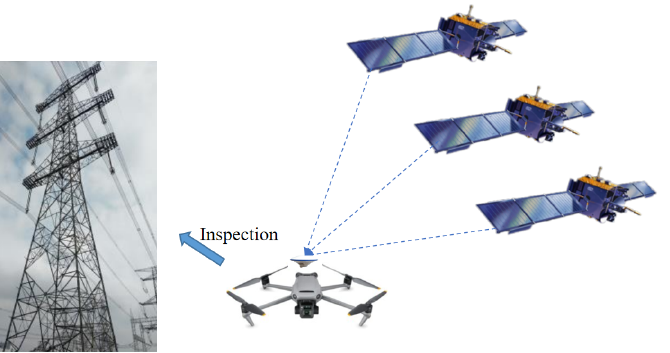
Figure 5. Application of satellite-positioning-and-image-based abnormality detection in power